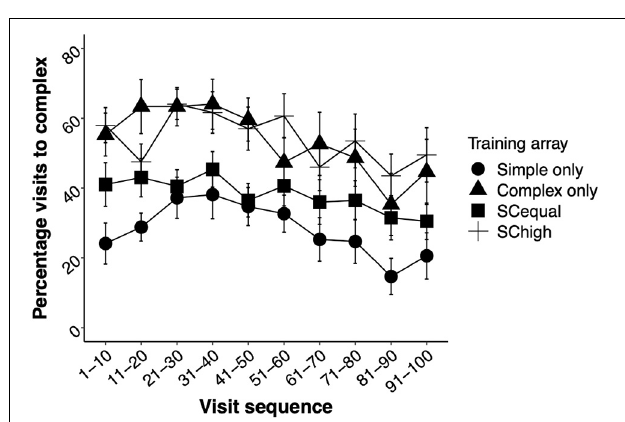
FIGURE 3 | The effects of experience during the test phase on the mean ± SE percentages of complex flowers chosen by the bees. Note that experience (visit number) was analyzed as a continuous variable in the statistical models. In the figure, however, visits are grouped into bins of 10 for graphical clarity.